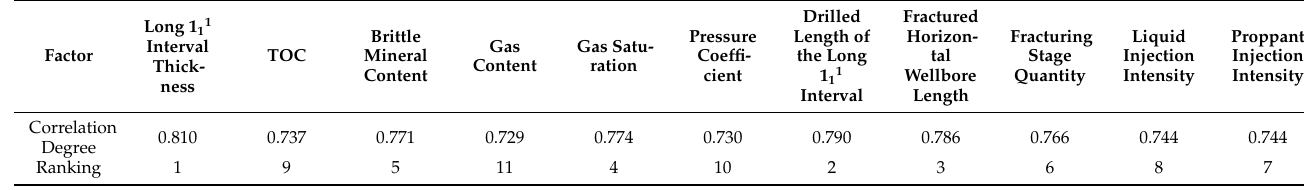
Table 3. Calculated correlation degrees between each factor and the EUR.